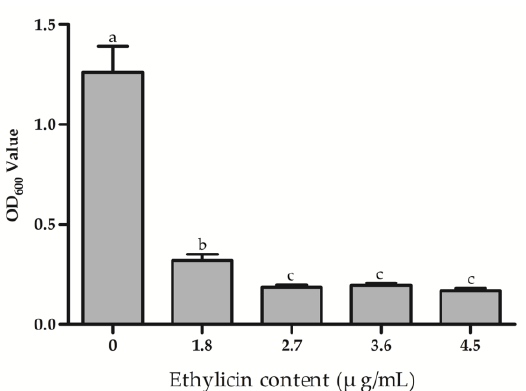
Figure 5. Biofilm formation content. The data represent the means ± SD of six replicate samples. The different letters (a–c) indicate significant differences at p < 0.05.